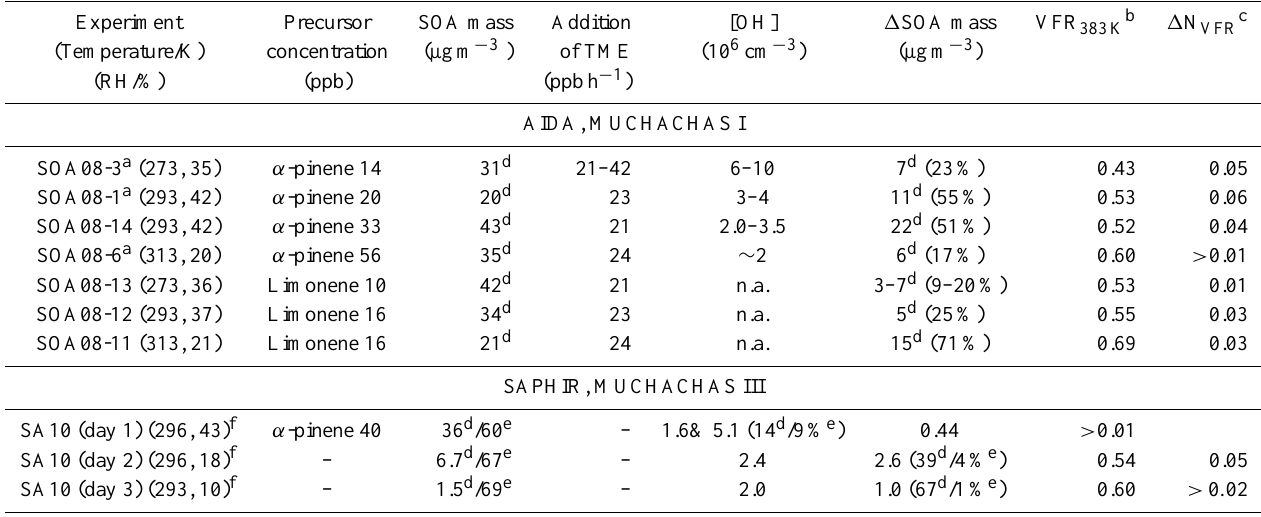
Table 1. Summary of experimental conditions. OH levels in AIDA were estimated by using the MCM 3.1 model. For SAPHIR the OH-levels were measured using LIF. The total SOA mass before OH production was initiated and 1 SOA mass produced during OH oxidation were estimated using density corrected SMPS